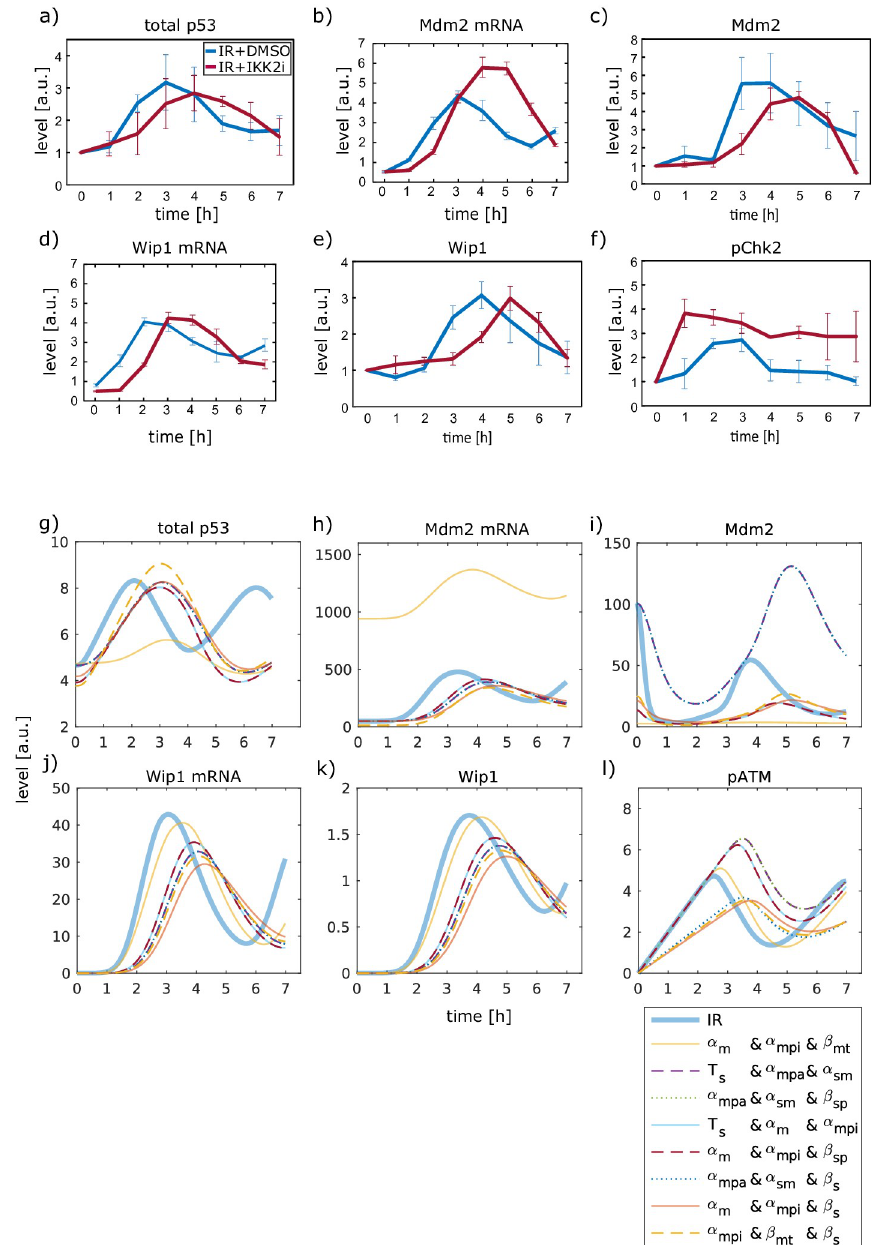
Fig 6. IKK2 inhibition leads to a delayed Wip1 and Mdm2 accumulation and increased pChk2 levels on the population level. Upon 10 Gy IR in A549 cells treated with DMSO or IKK2i, the levels of p53 (a), Mdm2 mRNA (b), Mdm2 protein (c), Wip1 mRNA (d), Wip1 protein (e) and pChk2 (f) were measured and quantified. Protein levels were determined by Western blot analysis. Data from independent experiments were normalized to values of the sample harvested 0 h post IR. Error bars indicate standard deviation of two biological replicates. mRNA expression was measured using qRT-PCR. β -actin was used as an internal control. Error bars indicate the minimum and the maximum value for the relative quantity of two biological replicates, each consisting of three technical replicates. Simulated dynamics of total p53 (g), Mdm2 mRNA (h), Mdm2 (i), Wip1 mRNA (j), Wip1 (k) and pATM (l) are shown for eight parameter combinations and IR